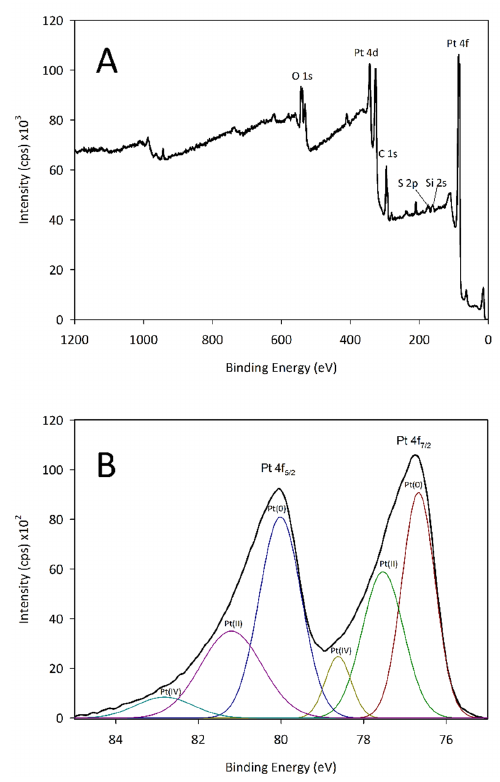
Figure 5. XPS spectra of the electrode surface after 300 cycles. Survey scan ( A ); high-resolution scan for platinum 4f ( B ).